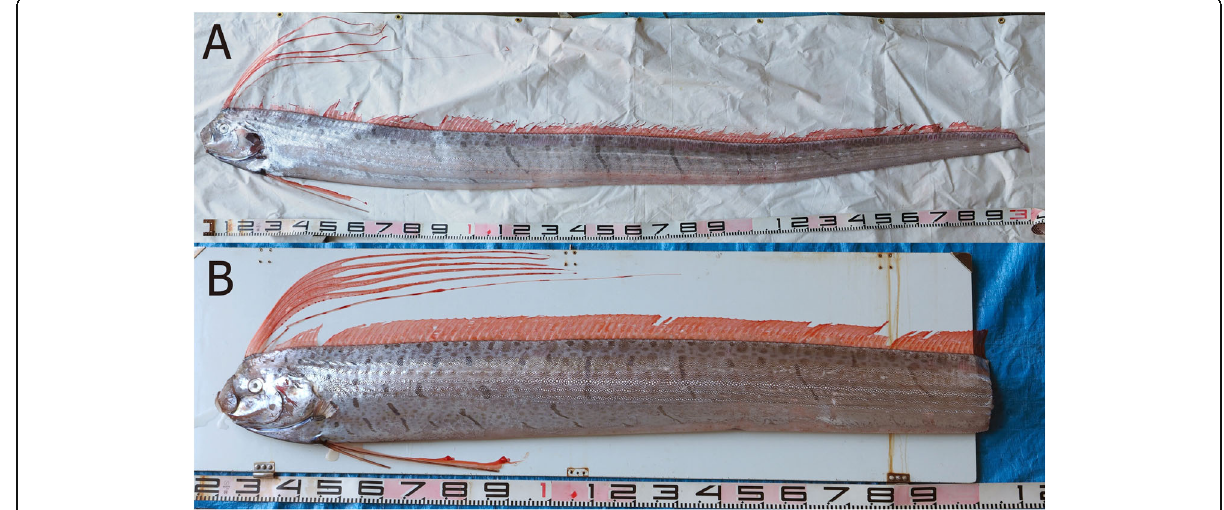
Fig. 1 Regalecus russelii pair used for artificial insemination. a : female, b :